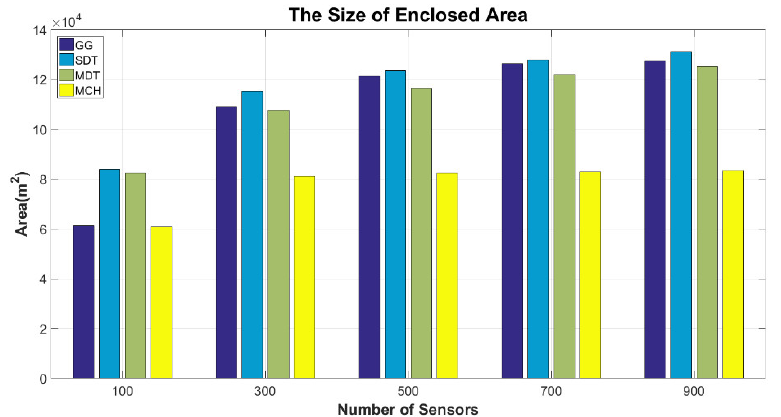
Figure 4. Compare the Size of the Enclosed Area. This experiment compares the enclosed area of the methods that use mobile sensors and the traditional ones, without mobile sensors. The precision of MDT and MCH is better than that of GG and SDT.